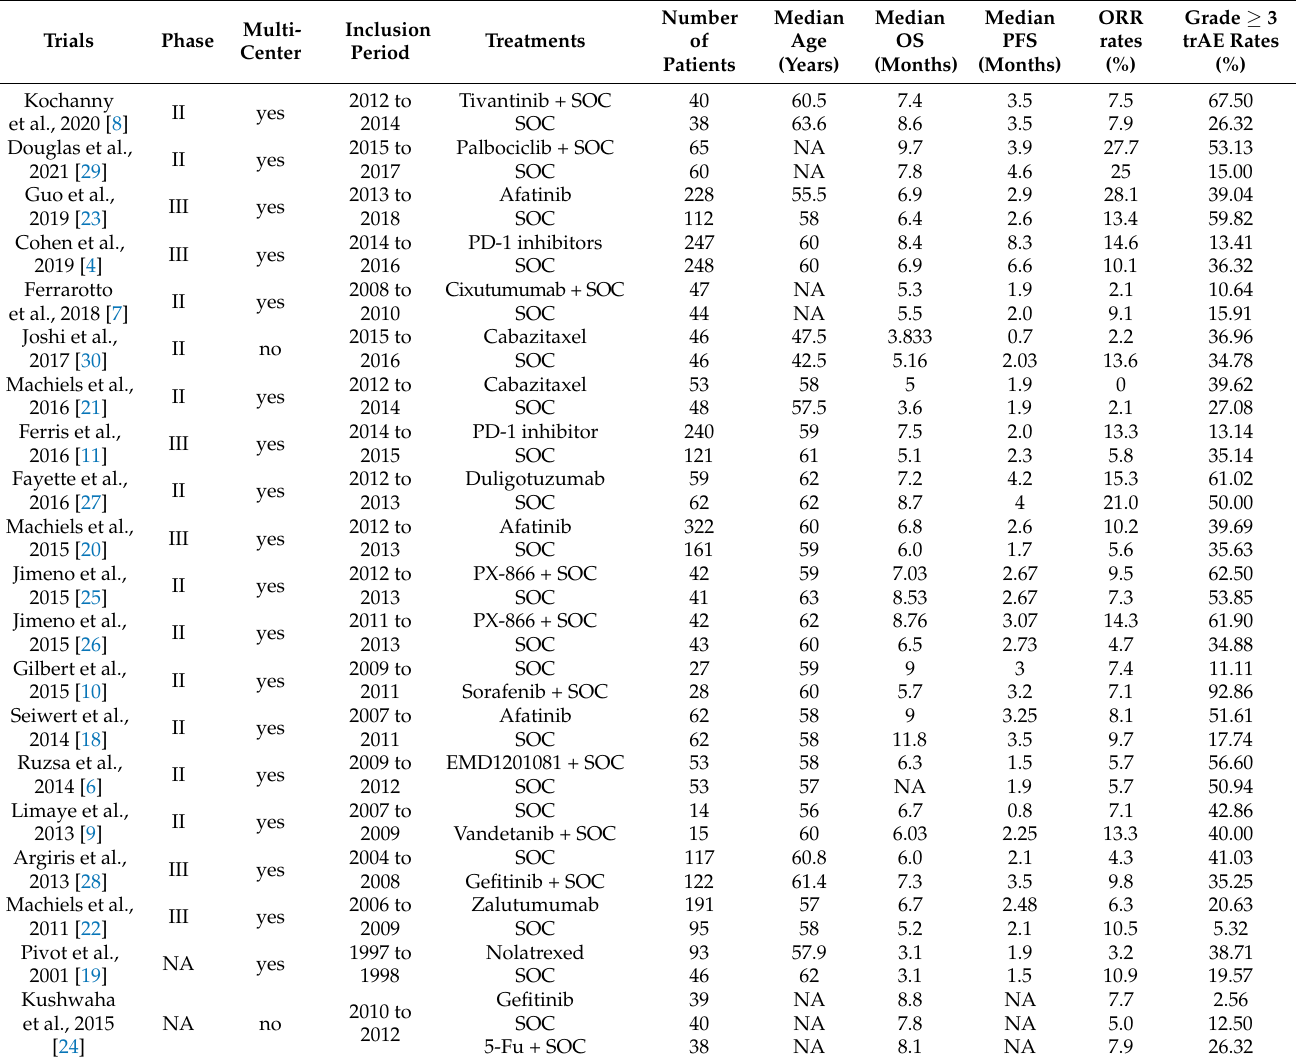
Table 1. Characteristics of the included